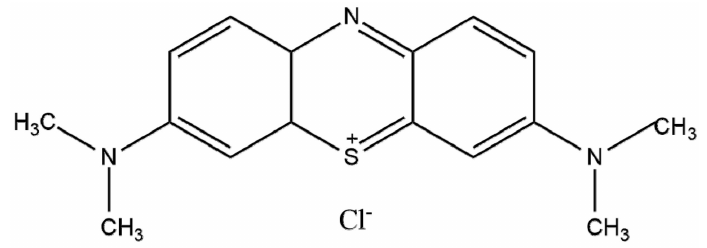
Figure 1. Chemical structure of methylene